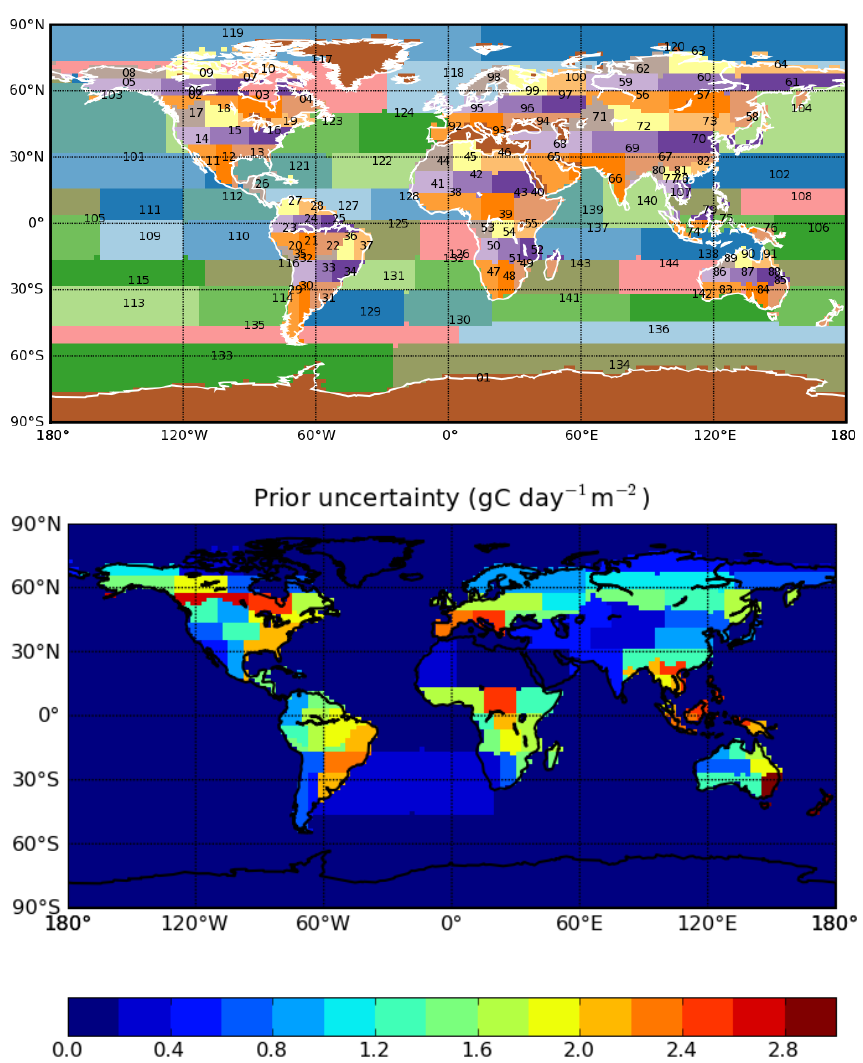
Fig. 1. The continental and ocean regions used to estimate CO 2 source and sinks (top panel), and associated prior uncertainties (gCday − 1 m − 2 lower panel), based on a coarser distribution from the TransCom-3 experiment (Gurney et al., 2002).